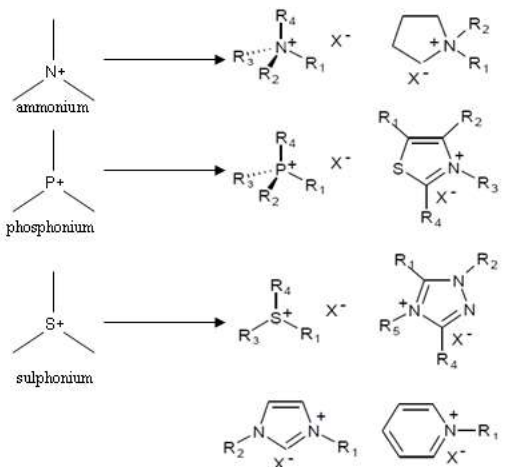
Figure 3. Cations and anions of ionic liquids with their structure and an exemplary type of substituent. X means: Tetrafluoroborate –BF 4 − , trifluoroacetate CF 3 COO − , chloride –Cl − , hexafluoroantimonate –SbF 6 − , bis trifluoro sulfonyl imide –(CF 3 SO 2 ) 2 N − , trifluorosulfane acetate –CF 3 SO 3 − [46,47].